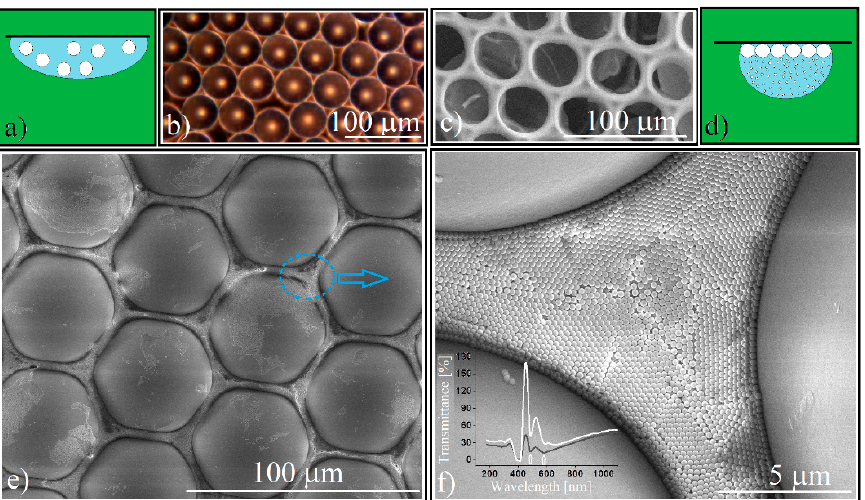
Figure 2. ( a ) Schematical of large size PS spheres single layer synthesis by hanging drop method; ( b ) optical microscopy image of 50 µm PS spheres single layer; ( c ) optical microscopy image of sodium silicate inverse-opal; ( d ) schematical of sub-micron silica colloid infiltration by hanging drop method; ( e ) SEM image of silica spheres self-assembled in the voids between PS spheres; ( f ) SEM image of silica colloidal crystal lattice, inset: transmittance of 50 µm PS and 0.264 µm silica spheres forming a patterned CC (white curve); transmittance of 0.264 µm silica spheres self-assembled as a block rectangular CC, by hanging drop method (black curve).